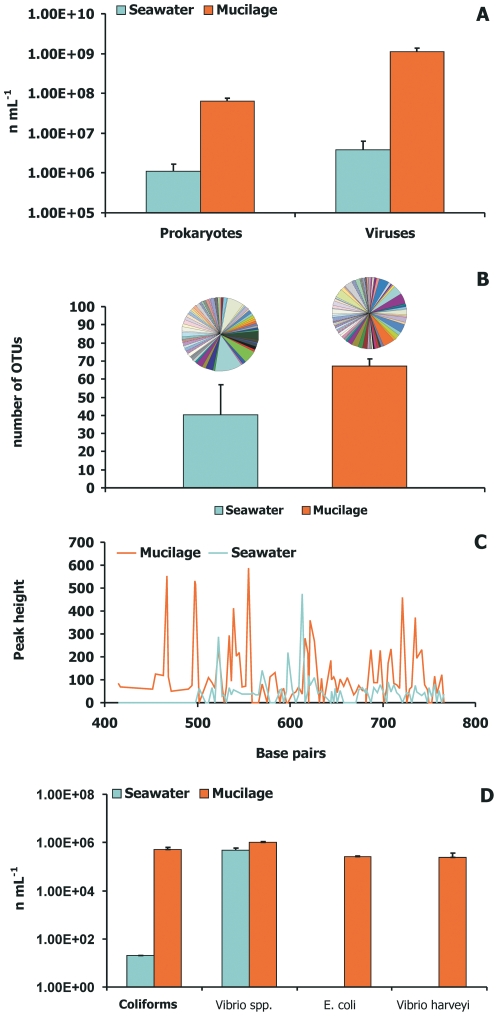
Microbial abundance and diversity in marine mucilage and surrounding seawater.(A) viral and prokaryotic abundance; (B) bacterial diversity (as OTU, Operational Taxonomic Units); (C) electropherograms of DNA extracted from a mucilage sample and surrounding seawater; (D) number of pathogens. Panel B illustrates diversity of bacterial assemblage: species in common are represented using the same colour. In Panel C, each peak corresponds to an interval of ±2 base pairs, is assumed to represent a different OTU, and the height of the peak is assumed to represent the quantity of each single OTU.